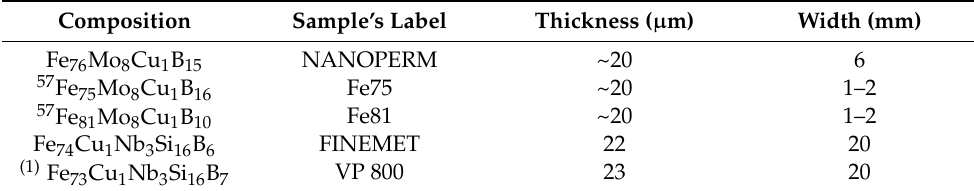
Table 1. Amorphous metallic alloys for ion irradiation experiments.